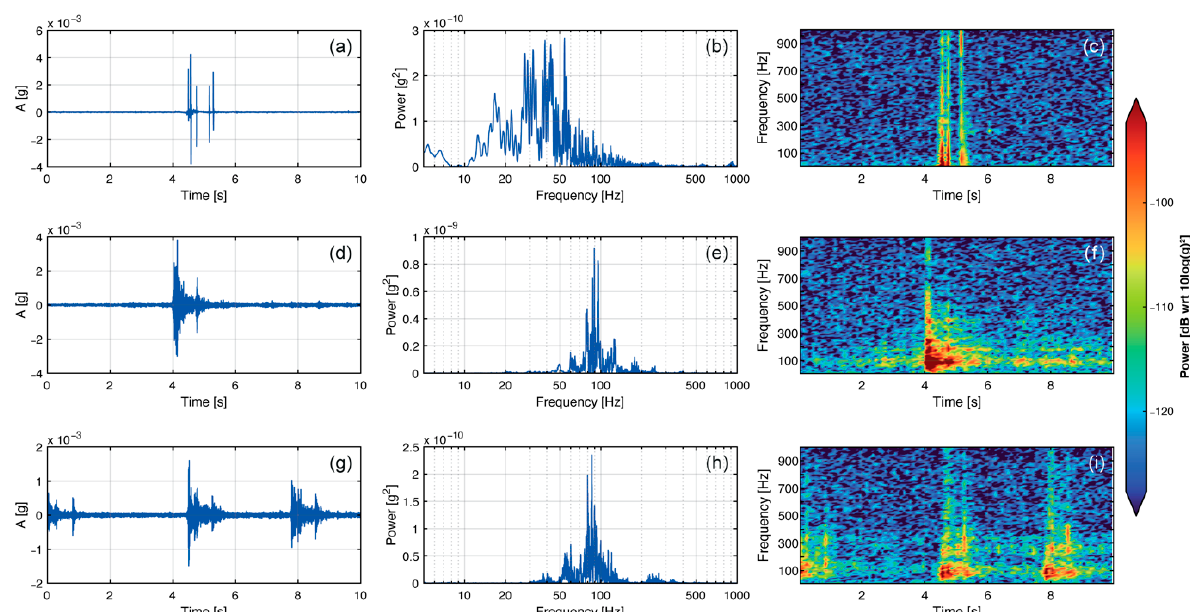
Figure 6. Example of electrical disturbances recorded at the Acuto field laboratory and manually classified as false events ( a – c ); example of a manually classified single MS event ( d – f ); example of a manually classified sequence of MS events ( g – i ).